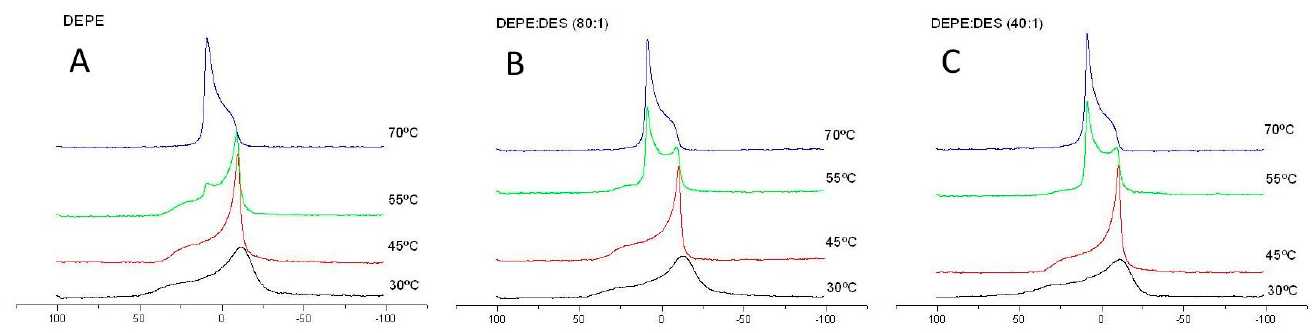
Table 2. Parameters extracted from the SADX diffractograms by using the GAP (global analysis program): zH, position of the headgroup Gaussian of the electron density profile; σ C, standard variation (width) of the Gaussian describing the hydrocarbon tails; dHH, headgroup peak − peak distance; dB, total bilayer thickness (polar head plus hydrophobic layer); dw, water layer.